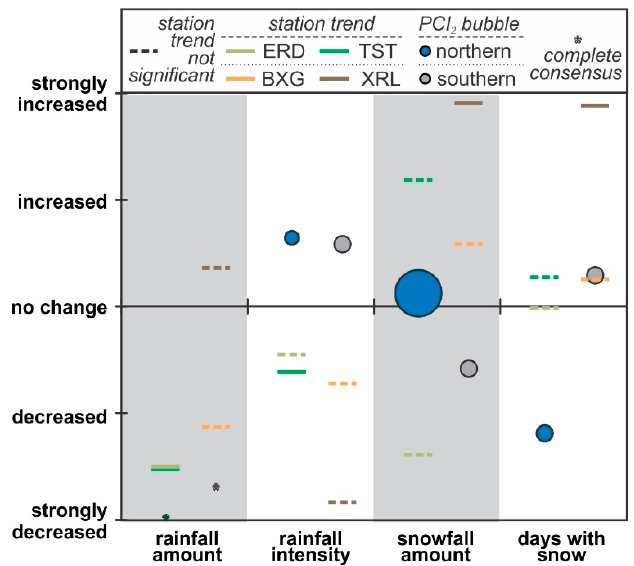
Figure 4. Change in precipitation amounts (rainfall, snowfall), rainfall intensity, and occurrence (days with snow) from station data with significant trends shown as solid lines and herder observations given as the Potential for Conflict Index (PCI 2 ). Non-significant trends are presented as dashed lines. The center of the PCI 2 bubble displays the mean herder observation on the y -axis, while the PCI 2 bubble size is the amount of consensus or disagreement (i.e., larger bubble = more disagreement and smaller bubble = less disagreement). The station trends were scaled based on the maximum rates of change and are presented using three-digit codes: ERD is Erdenemandal and TST is Tsetserleg, both representing the Northern soums ; BXG is Bayankhongor and XRL is Khoriult, both representing the Southern soums .